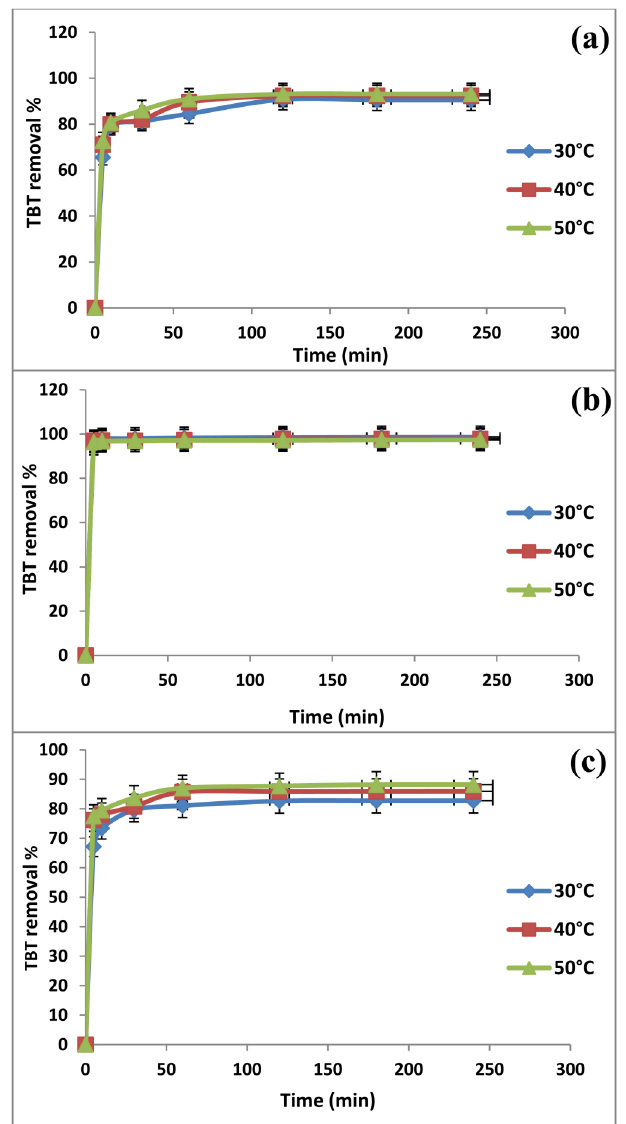
Figure 4. Effect of contact time on removal of TBT onto MCM-TDI-C4 ( a ), MCM-TDI- PC4 ( b ) and MCM-TDI-C4S ( c